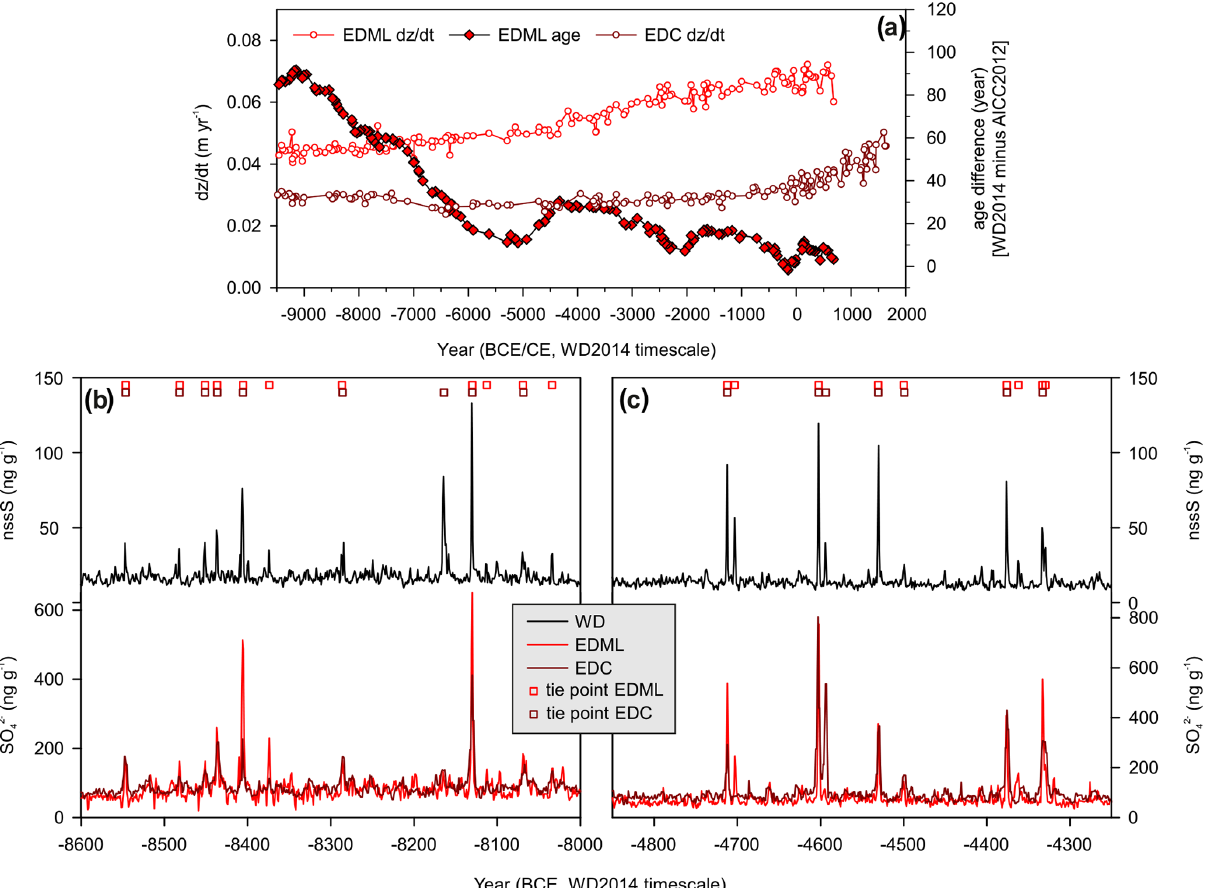
Figure 1. Volcanic synchronization for Antarctica: panel (a) shows the changes in mean annual layer thickness (d z/ d t ) and age difference (WD2014 minus AICC2012 – Veres et al., 2013) calculated between volcanic tie points for the EDML and EDC ice cores, respectively; panel (b) shows the WD non-sea-salt sulfur (nssS) record as well as the EDML and EDC sulfate records for the 8600–8000BCE time period and volcanic tie points; panel (c) shows the same records for the 4850–4250BCE time period. All records are shown at an annual resolution on the annual-layer-counted WD2014 chronology (Sigl et al.,